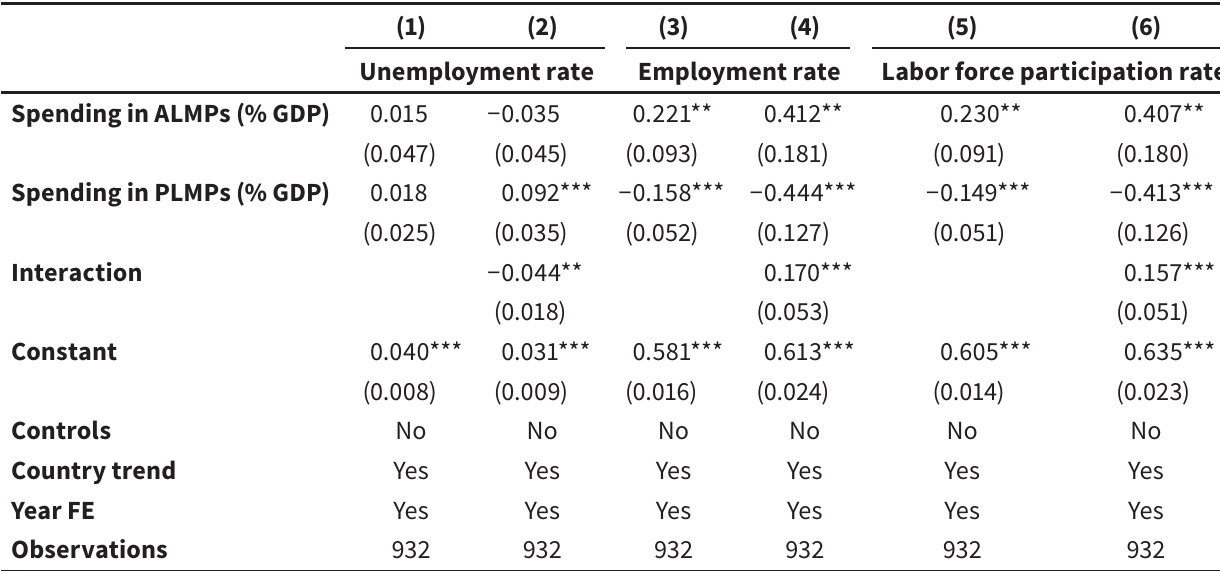
Results for the unemployment rate, employment-to-population ratio, and labor force participation rate estimated with